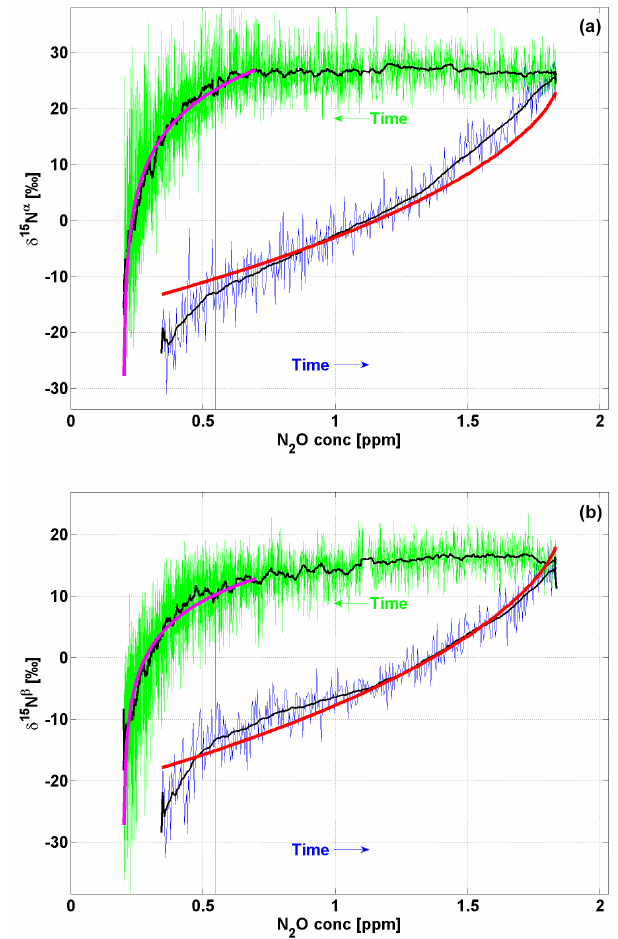
Figure 6. (a) δ 15 N α as a function of N 2 O concentration produced by P. fluorescens with the modeled Rayleigh-type distillation. High- resolution CRDS data (blue and green line) and 5min running av- erage (black line). The red and magenta curves are the modeled Rayleigh-type distillation curves for the production and reduction of N 2 O, respectively. The blue arrow indicates the direction of time during production of N 2 O whereas the green arrow indicates the di- rection of time during reduction of N 2 O. (b) δ 15 N β as a function of N 2 O concentration produced by P. fluorescens with the modeled Rayleigh-type distillation. High-resolution CRDS data (blue and green line) and 5min running average (black line). The red and ma- genta curves are the modeled Rayleigh-type distillation curves for the production and reduction of N 2 O, respectively. The blue arrow indicates the direction of time during production of N 2 O whereas the green arrow indicates the direction of time during reduction of N 2